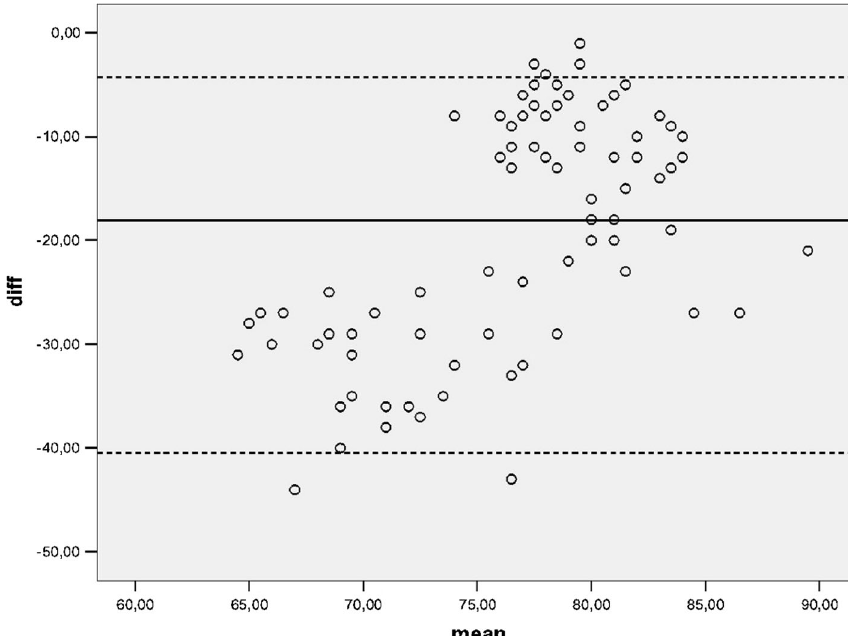
showing the test–retest results of 90 patients who completed the Italian version of the Kerlan–Jobe Orthopaedic Clinic (KJOC) questionnaire. Solid line mean difference. Dashed lines upper and lower 95% confidence